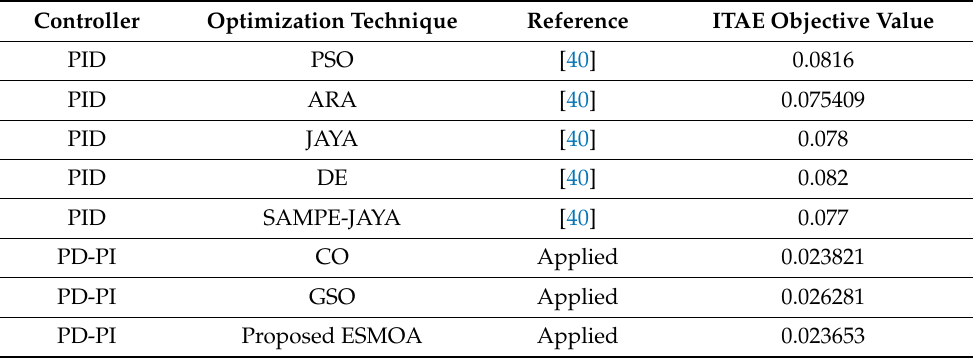
Table 6. Comparison of the proposed ESMOA outcomes with other reported results in terms of ITAE for Case 2.